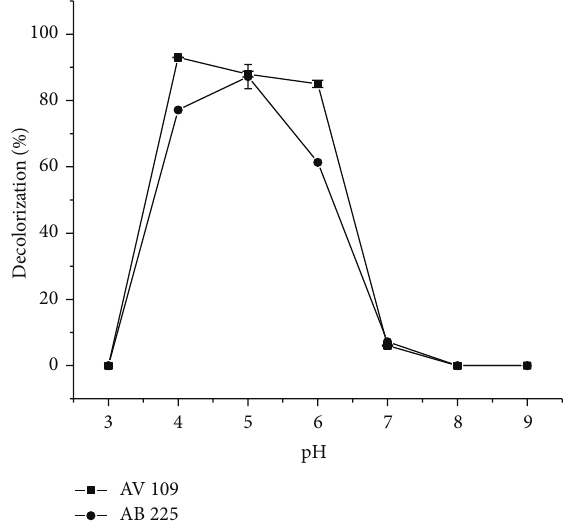
Figure 6: The influence of temperature on AB 225 and AV 109 decolorization. Other reaction conditions were optimal for both